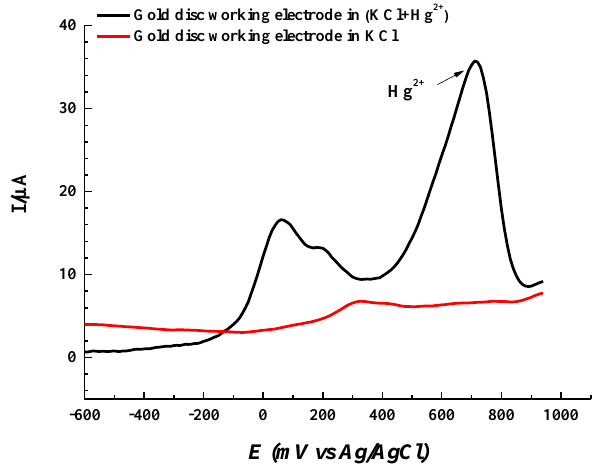
Figure 2. Characteristic peaks of mercury oxidation on gold electrode in H 2 O/KCl 0.1 M